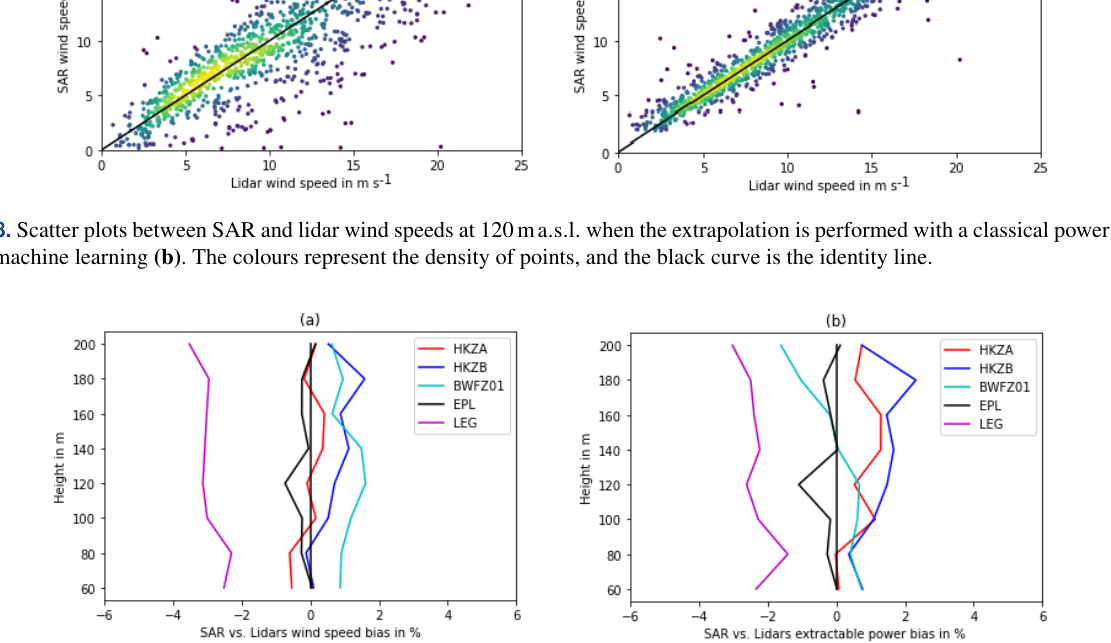
Figure 9. Biases in SAR extrapolated wind speed (a) and extractable wind power (b) versus each lidar as a percentage. The results with LEG lidar are less accurate due to its low number of collocated SAR